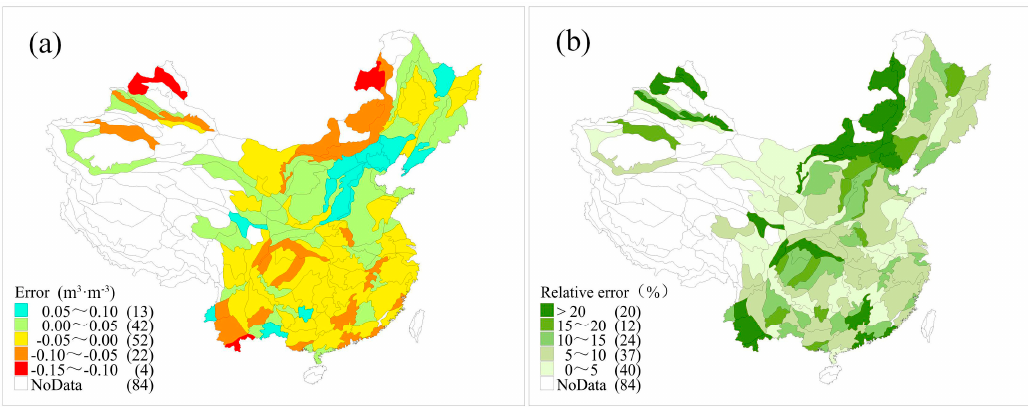
Figure 8. Distribution of ( a ) error and ( b ) relative error between in situ field capacity and ensemble field capacity. Blank regions represent areas in which number of station was less than two. Numbers in parentheses represent the sum of corresponding regions. Error was calculated by subtracting ensemble field capacity from in situ field capacity.